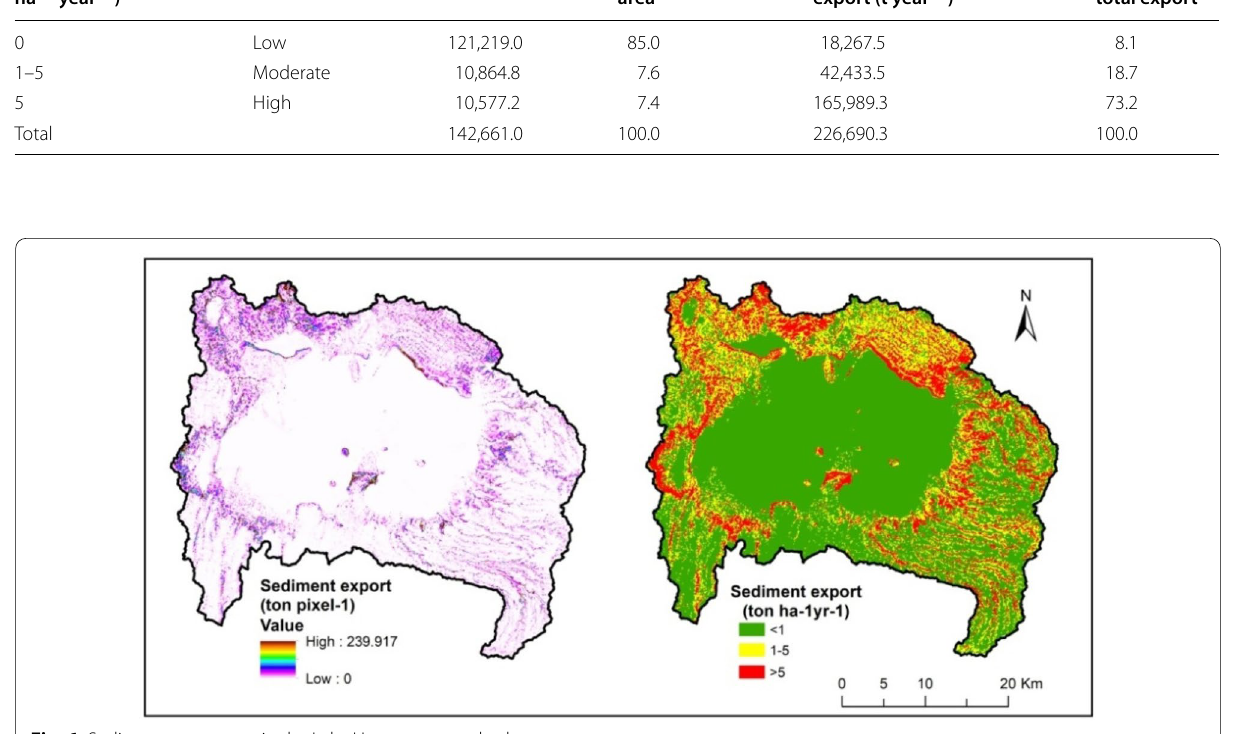
Fig. 6 Sediment export rate in the Lake Hawassa